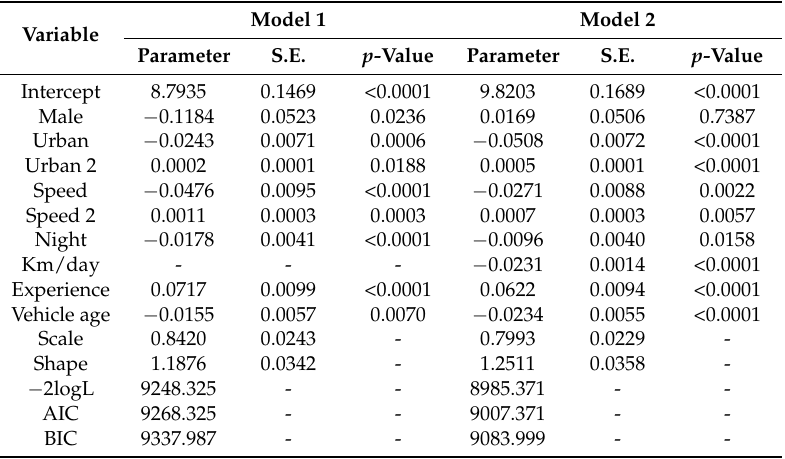
Table 3. Weibull model estimates of the time to the first accident for all